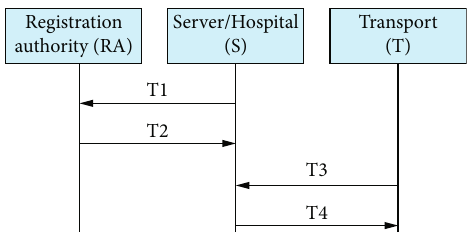
Figure 7: Registration phase of the emergency medical response